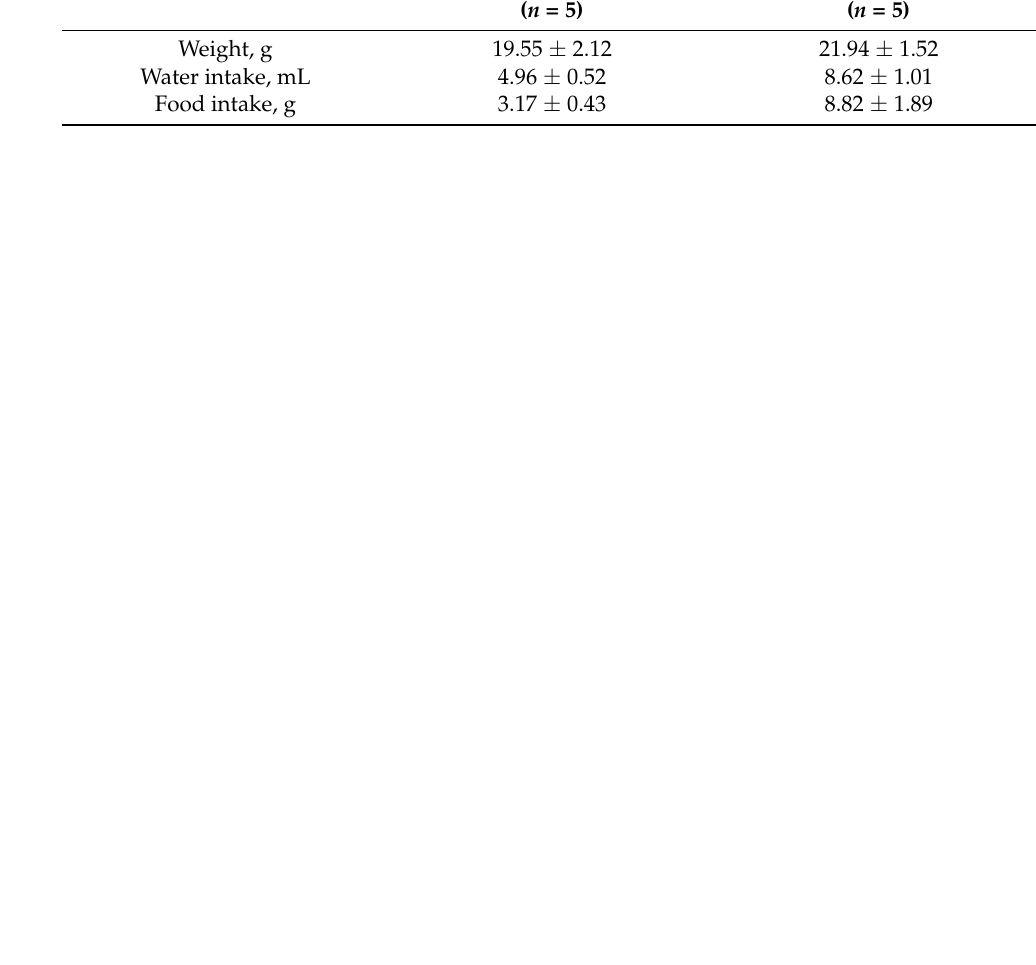
( D ) Figure 2. A 2% KCl diet stimulates MST3 expression. MST3 protein expression was detected in WT mice fed the ( A ) control (n = 3 or 4 animals), low Na (LNa), 1.43% Na or ( B ) 2% KCl diets for 16 days (n = 3 animals/group) . The sodium, potassium, chloride and water contents in the diet are indi-